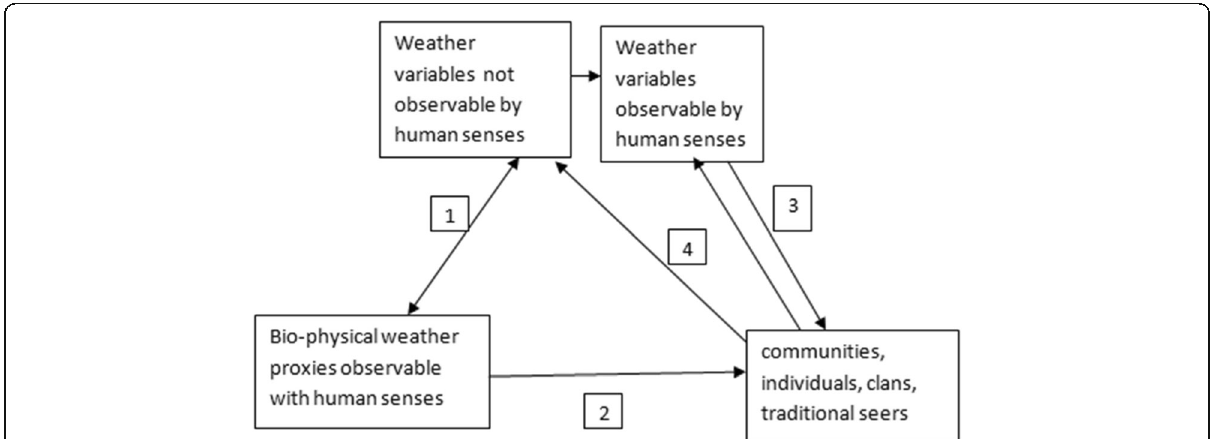
Fig. 1 Schematic presentation of the production of weather forecasting knowledge among Afar pastoralists (numbers are the order in which the dynamic takes